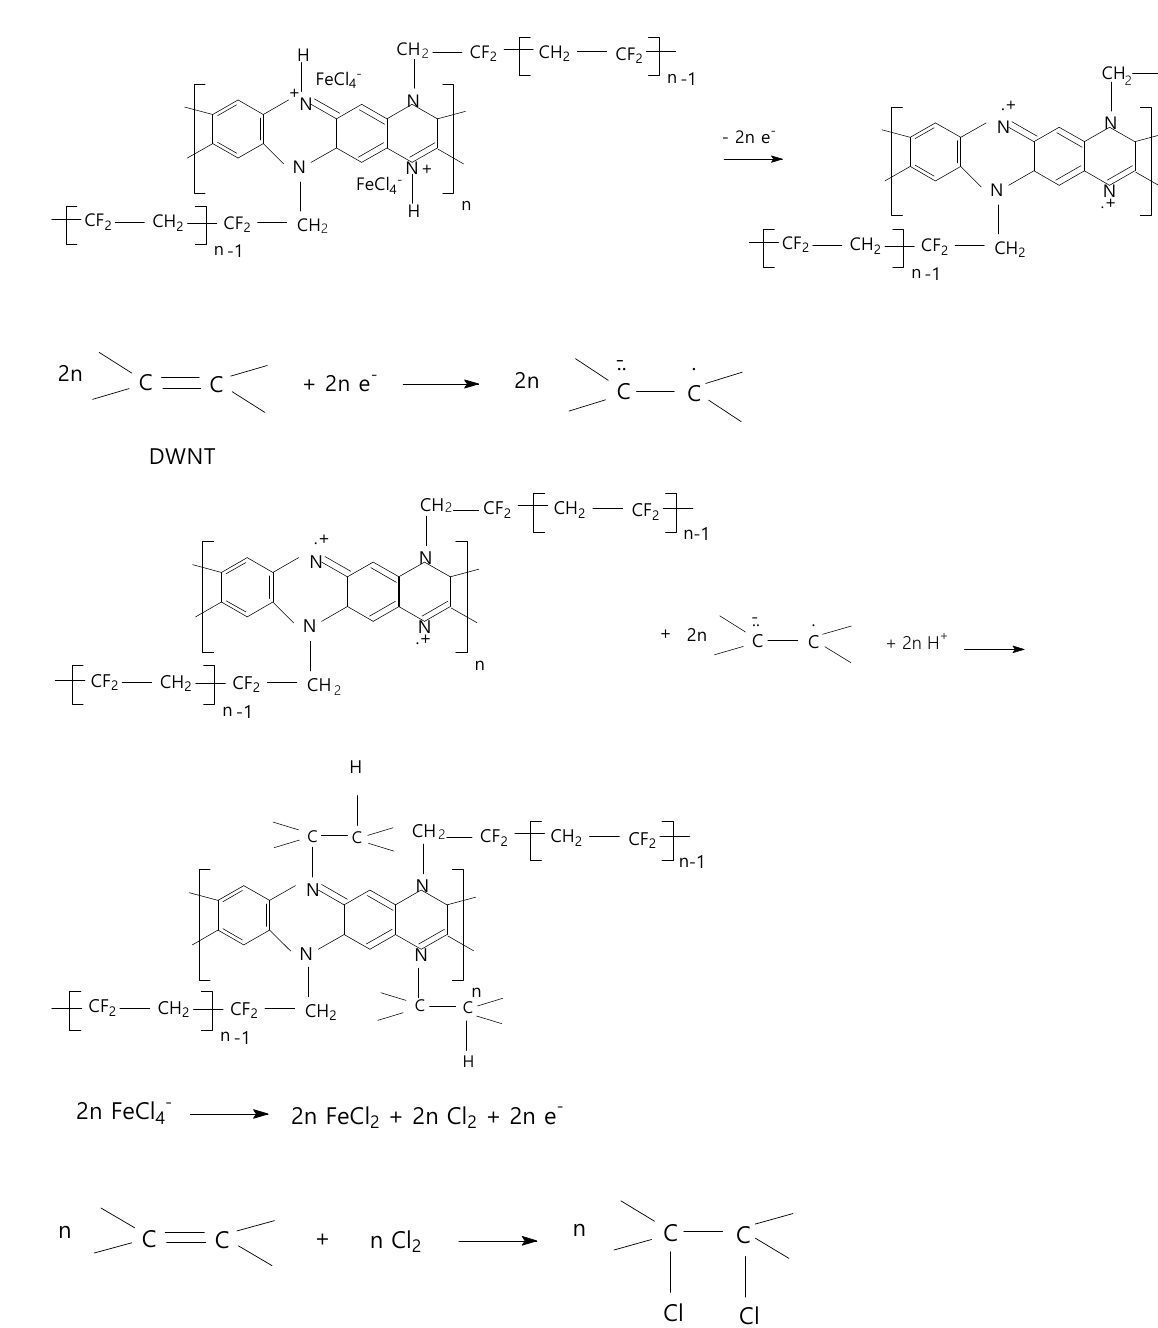
Figure 7b 1 ) and 7.17 × 10 4 counts/sec (F sample, Figure 7c 1 ); (ii) a progressively decrease in the intensity of the PL band with the peak at 541–544 nm from 4.76 × 10 5 counts/sec (B sample, Figure 6b 2 ) to 2.48 × 10 5 counts/sec (D sample, Figure 7a 2 ), 1.67 × 10 5 counts/sec (E sample, Figure 7b 2 ) and 7.8 × 10 4 counts/sec (F sample, Figure 7c 1 ); and (iii) the increase in the intensity of the emission band situated in the spectral range 650–800 nm, whose intensity increases as the DWNTs amount varies from 5 mg to 10 mg and 20 mg in the mixture of the chemical polymerization reaction of the D, E and F composites. These results clearly demonstrate the role of DWNTs as POPD PL quenching agents.